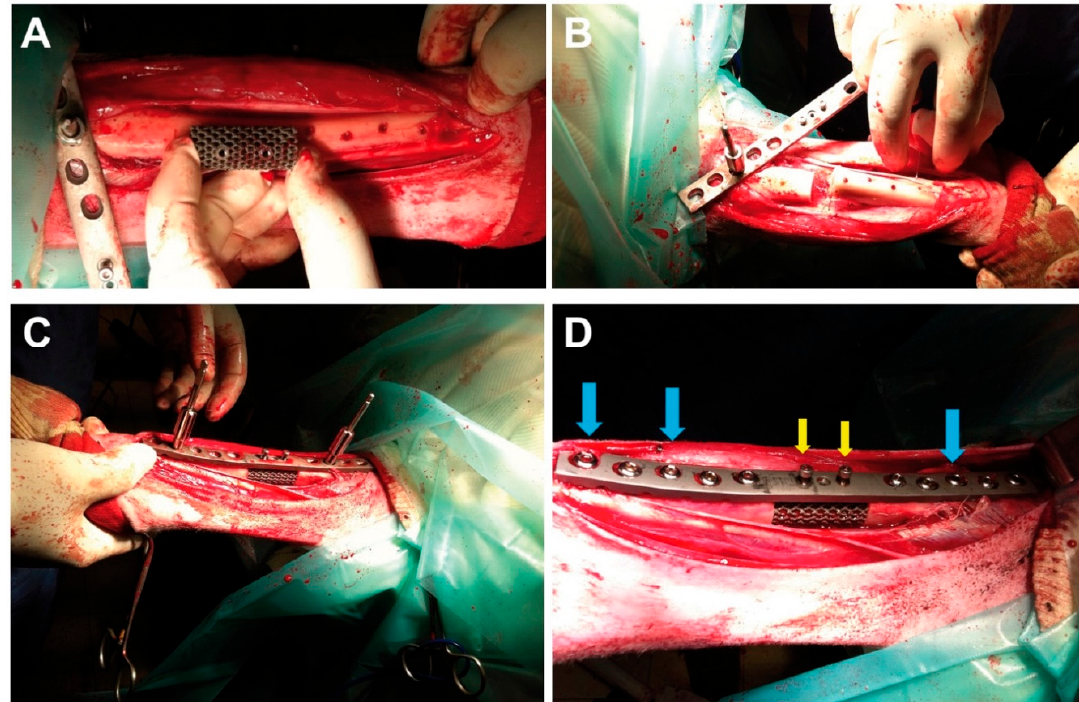
Figure 2. Photographs illustrating the surgical implantation of a titanium scaffold (experimental group). ( A ) The tibia has been exposed, and the scaffold is shown next to it. ( B ) A five-centimeter full-thickness defect has been practiced. ( C ) The scaffold has been placed on the defect, and the tibia is being stabilized with a custom-made osteosynthesis plate. ( D ) Final result, showing the scaffold and osteosynthesis plate, which is held in place by screws that anchor in the bone (blue arrows) or in the scaffold itself (yellow arrows). In the CONTROL group, the surgical procedure was similar, but the defect was filled with hydroxyapatite.